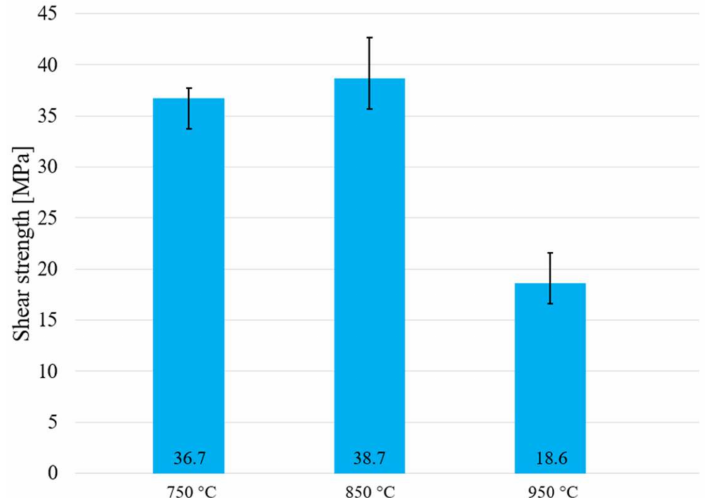
Figure 20. Shear strength of soldered joint of SiC/Ni fabricated with solder type Sn5Sb3Ti and dependence on soldering temperature.